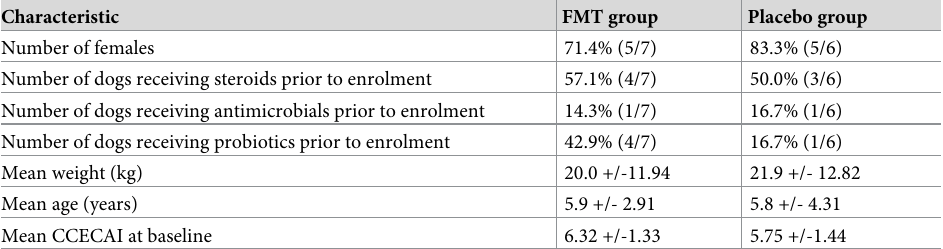
Table 1. Characteristics of dogs in the FMT and placebo groups at baseline.